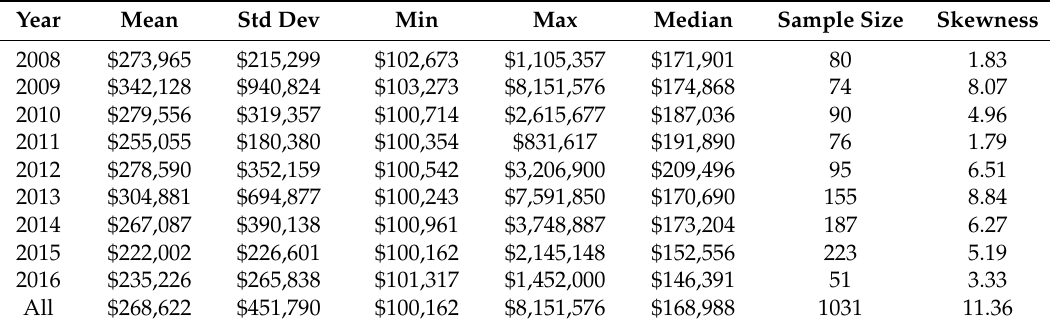
Table 1. Descriptive statistics of claims by year (2008–2016).